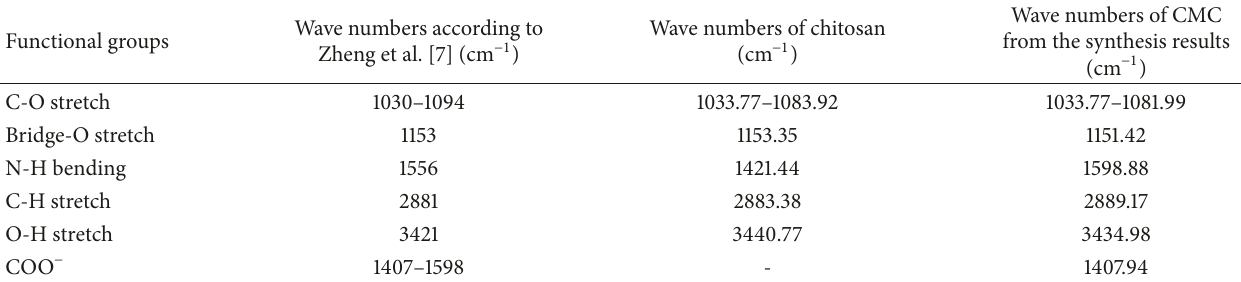
Table 1: Analysis of functional groups of chitosan and CMC using